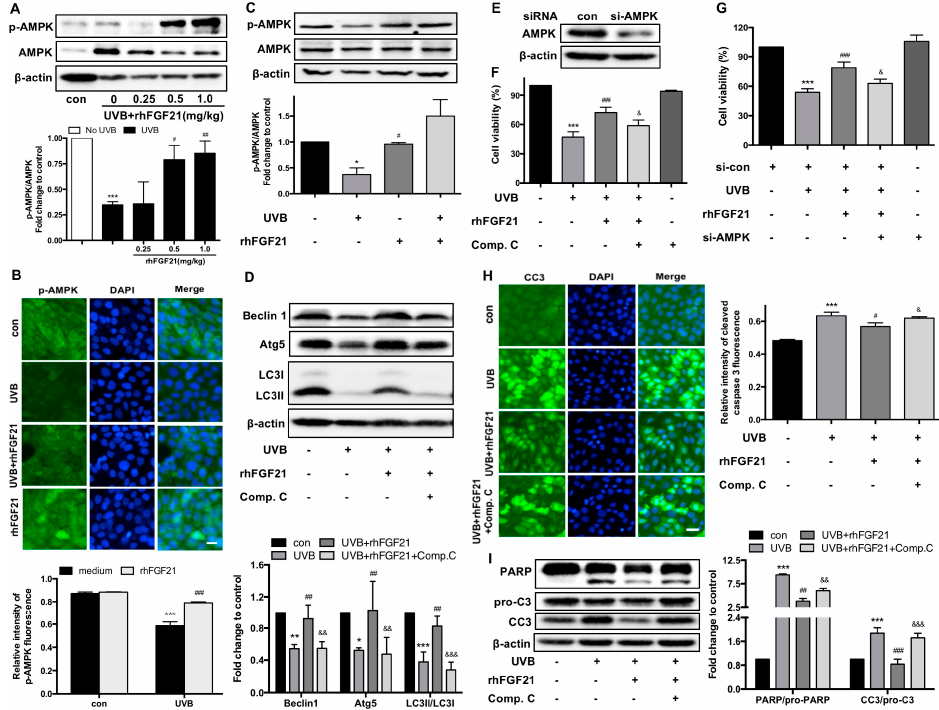
Figure 6. RhFGF21 protects HaCaT cells from UVB-induced apoptosis by activating AMPK-mediated autophagy. ( A ) The expression of p-AMPK and AMPK proteins in epidermal cells were detected by Western blot analysis, and quantitative analysis of the intensity of p-AMPK/AMPK. ( B ) Immunofluorescence confocal microscopy images of p-AMPK in HaCaT cells. Green fluorescence represents the expression of p-AMPK protein, blue fluorescence represents nucleus DAPI. Scale bar = 25 μ m. Quantitative analysis of the intensity of p-AMPK. ( C ) The expression of p-AMPK and AMPK proteins were detected by Western blot analysis, and quantitative analysis of the intensity of p-AMPK/AMPK. ( D ) Cells treated with AMPK inhibitor (Compound C, Comp. C, 1 mM). The protein levels of Beclin 1, Atg5 and LC3 were determined by Western blot and quantified by Western blot and ImageJ, respectively. ( E ) AMPK expression was silenced by transfection with siRNA. ( F , G ) Effect of inhibiting or silencing AMPK on cell viability. Comp. C, 1 mM; si-AMPK, 20 nM. ( H ) Cellular expression of active caspase-3 was analyzed by confocal microscopy. Green fluorescence represents the expression of active caspase-3 (CC3) protein, blue fluorescence represents nucleus DAPI. Scale bar = 25 µ m. ( I ) The protein levels of PARP, pro-caspase 3 (pro-C3) and active caspase 3 (CC3) were detected by Western blot and quantified by Western blot and ImageJ, respectively. Data are means ± SD of three independent experiments, * p < 0.05, ** p < 0.01, *** p < 0.001 versus epidermal cells or HaCaT cells not exposed to UVB radiation; # p < 0.05, ## p < 0.01, ### p < 0.001 versus UVB-irradiated epidermal cells or HaCaT cells; & p <